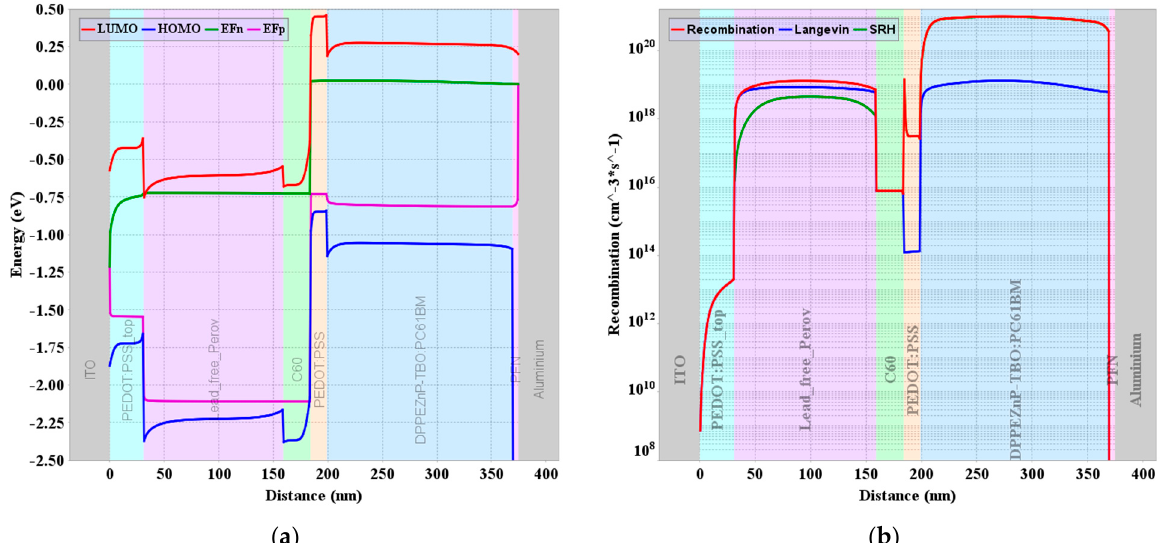
Figure 9. ( a ) Energy band profile at MPP showing the alignment of electron and hole QFLs ( E Fp and E Fn ). ( b ) Recombination rate along the tandem cell at MPP. E Fn ). ( b ) Recombination rate along the tandem cell at